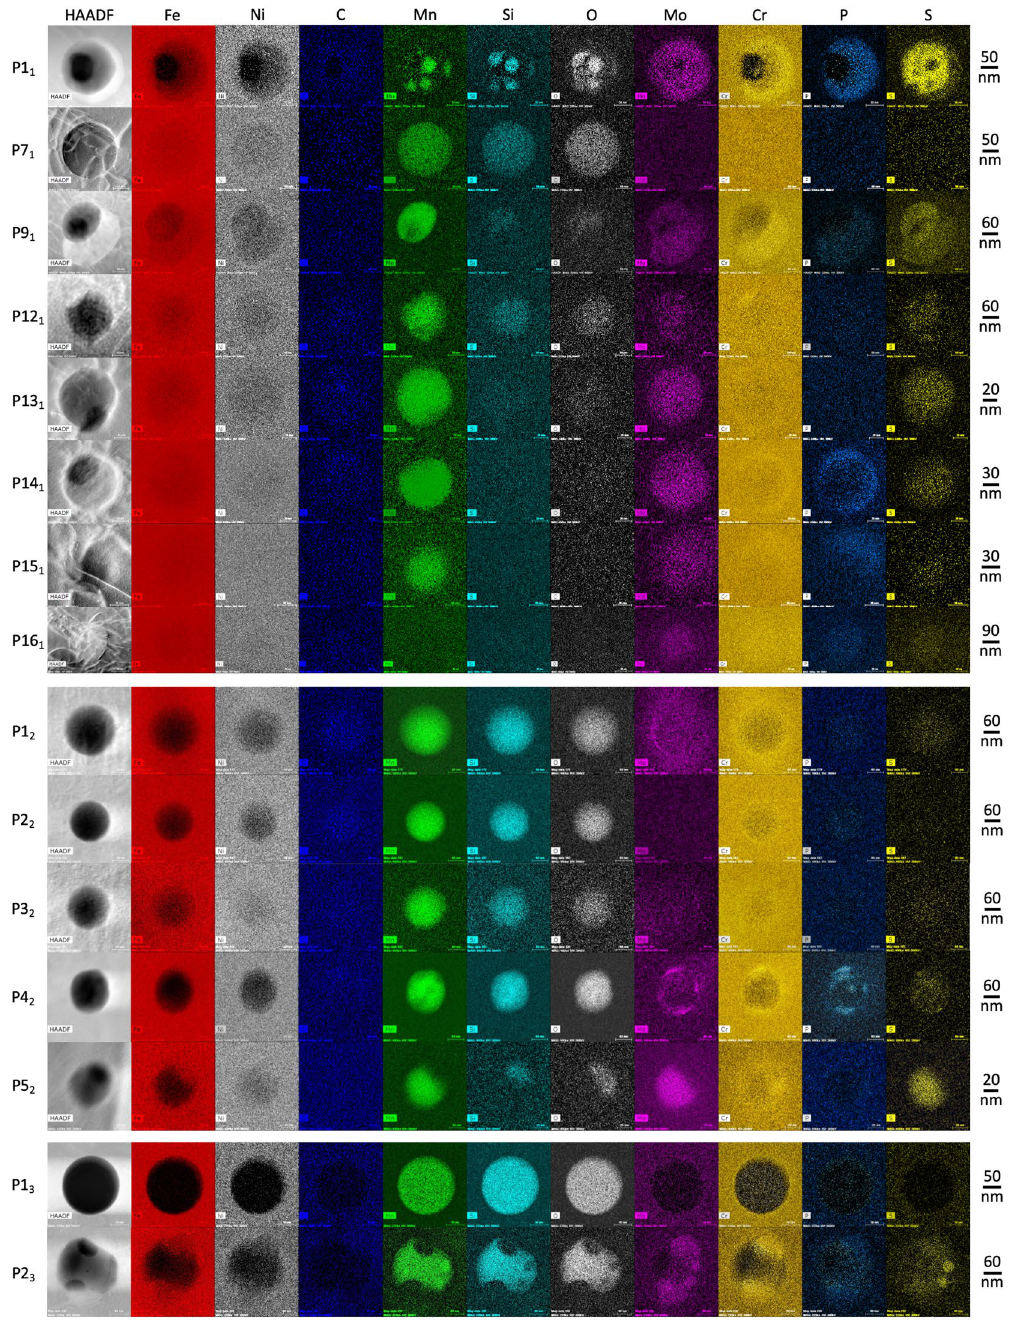
Figure 3. STEM HAADF images and EDS maps of all non-oxide and mixed precipitates, and at maximum one oxide precipitate, in L1–L3. To facilitate visualization, picture corrections have been made for all the EDS maps. ImageJ and Microsoft PowerPoint have been used to prepare this image. HAADF images and EDS maps have been acquired using the TIA v4.2 (FEI https:// www. fei. com) and the Esprit v1.9 (Brucker https:// www. bruker. com) software, respectively. Fiji v2.1.0/1.53c (https:// fiji. sc/) and Microsoft PowerPoint have been used to prepare this